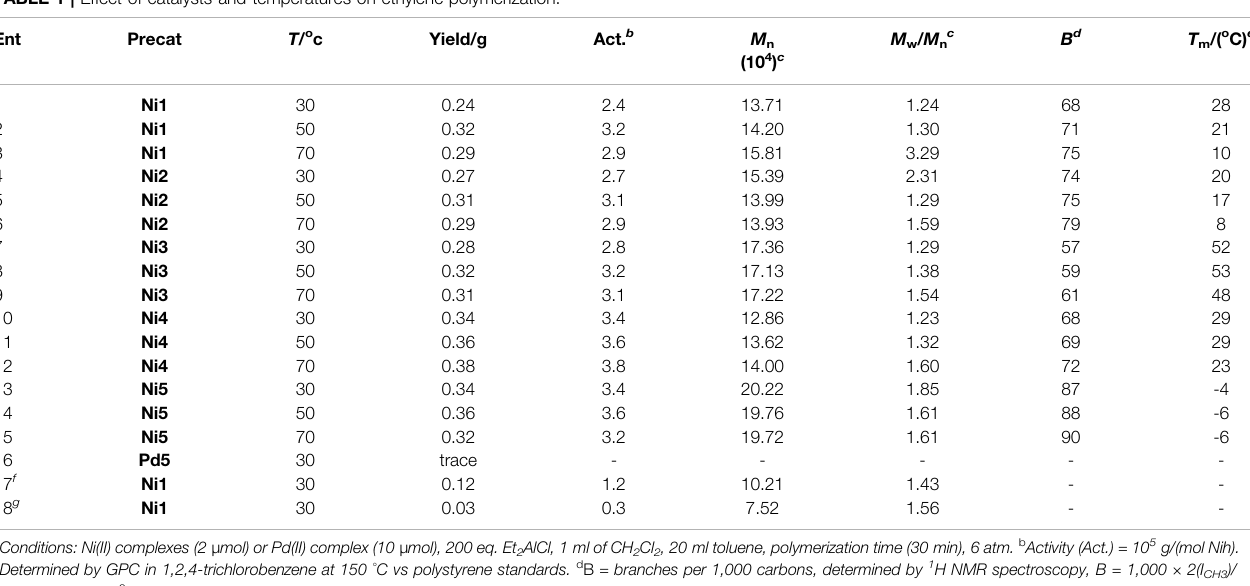
TABLE 1 | Effect of catalysts and temperatures on ethylene polymerization. a